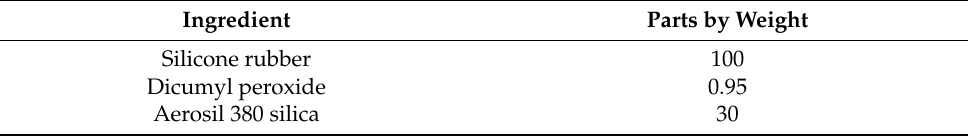
Table 1. Composition of rubber mixtures containing silicone rubber (MVQ). Ingredient Parts by Weight Silicone rubber 100 Dicumyl peroxide 0.95 Aerosil 380 silica